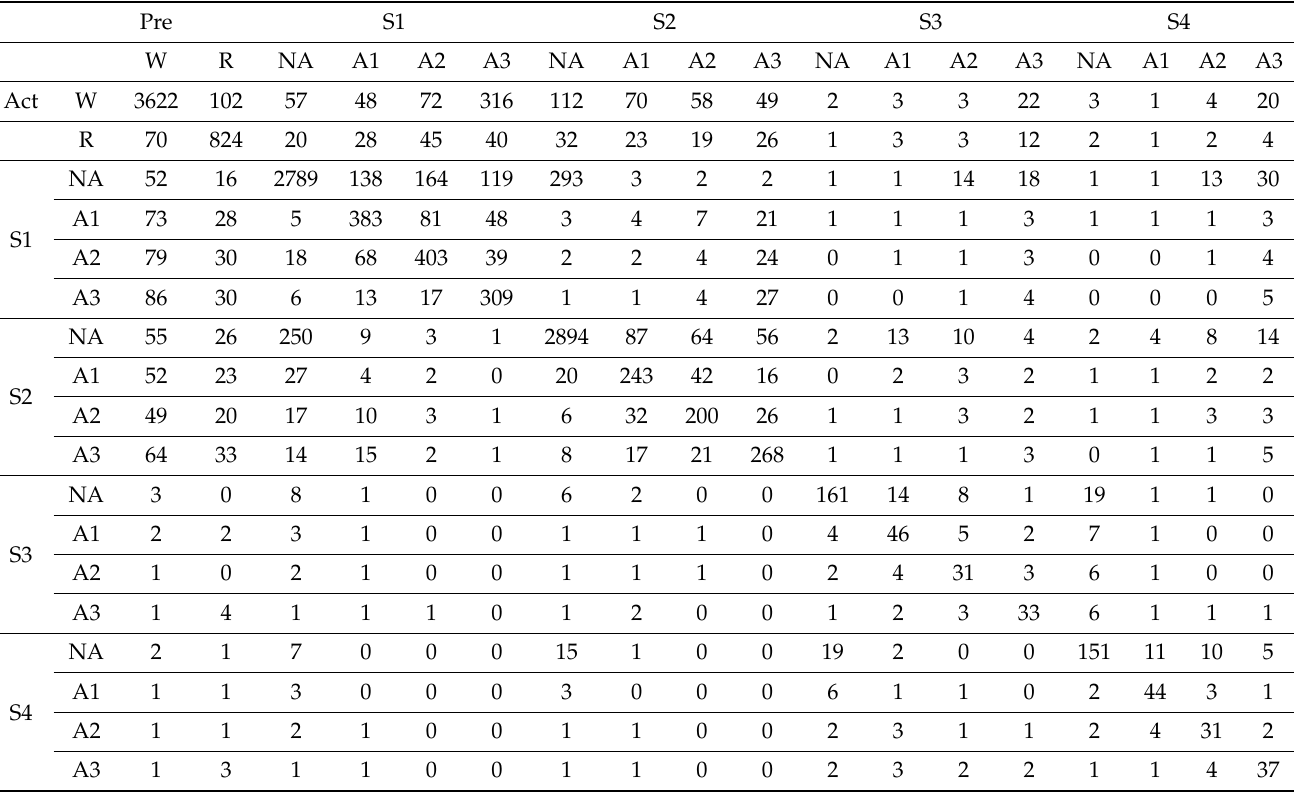
Table 2. The confusion matrix of the sleep stage